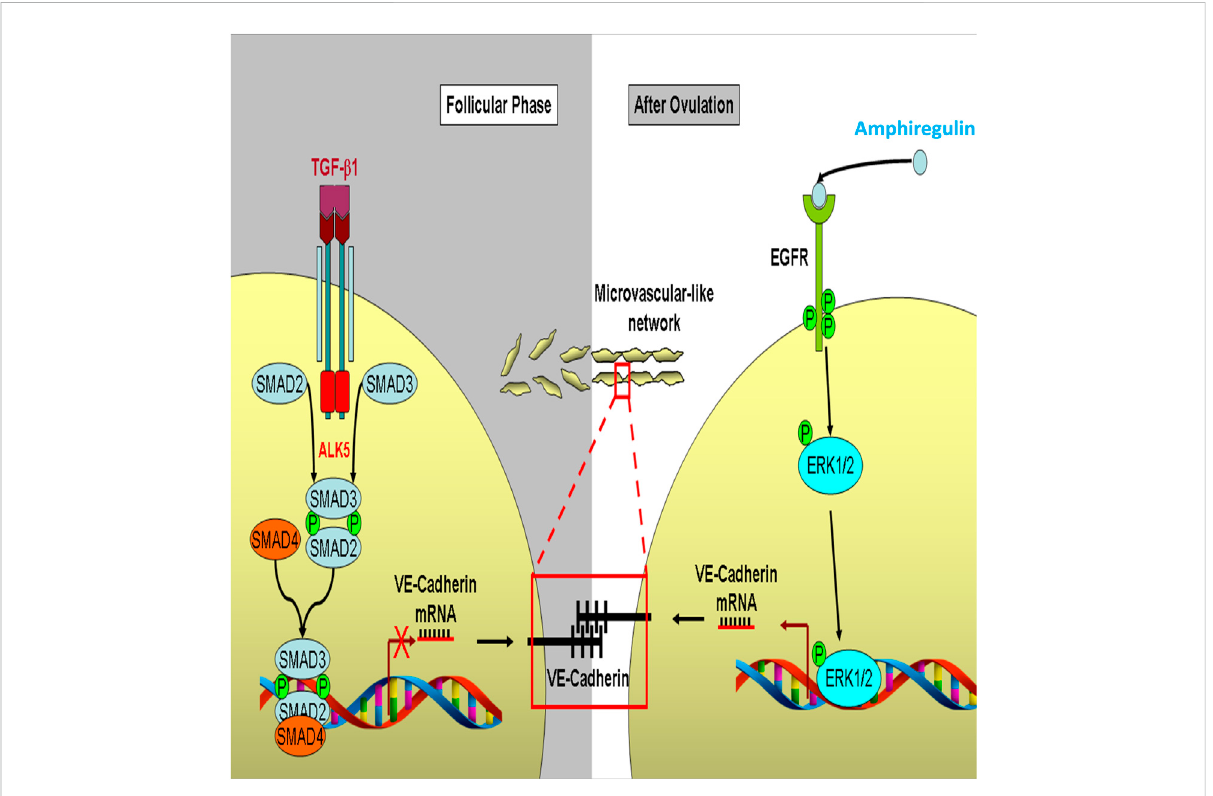
FIGURE 11 A proposed schematic diagram for the regulation of VE-cadherin and microvasculature-like formation in response to AREG and TGF- β 1 in human granulosa cells. During the follicle phase, TGF- β 1 binds to ALK5 and type II receptors in human granulosa cells which subsequently phosphorylates SMAD2/3, then combine with SMAD4, which in turn suppresses the transcription of VE-cadherin. The suppression of VE-cadherin inhibits the formation of intercellular microvascular-like networks. In contrast, after ovulation, human granulosa cells are luteinized to produce amphiregulin induced by LH. Amphiregulin binds to EGFR in an autocrine or paracrine manner and phosphorylates its downstream molecule ERK1/ 2 and subsequently promotes VE-cadherin expression, which fi nally promotes the formation of an intercellular microvasculature-like network during corpus luteum